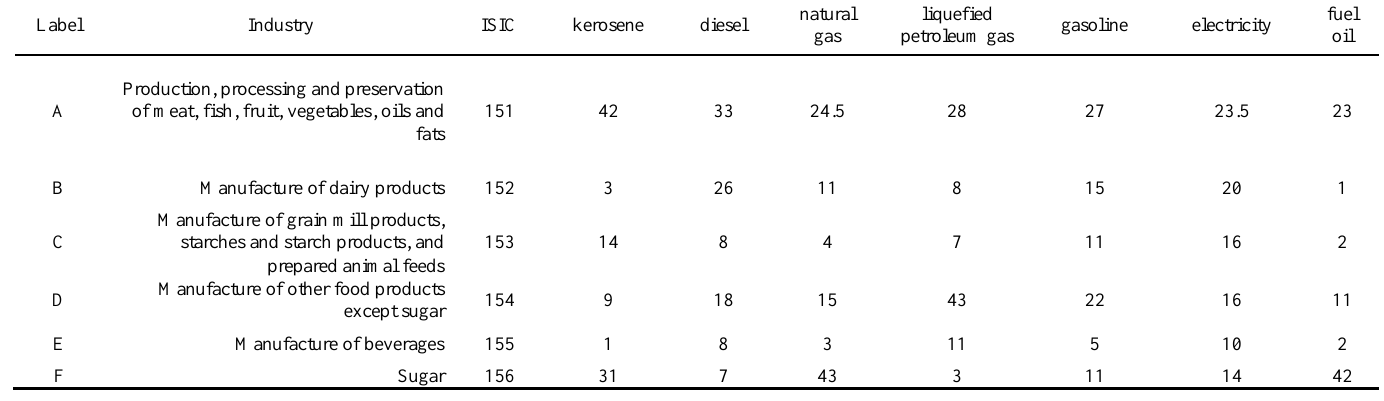
Table 2. Percentage share of energy carriers in food and beverage industries of Iran.